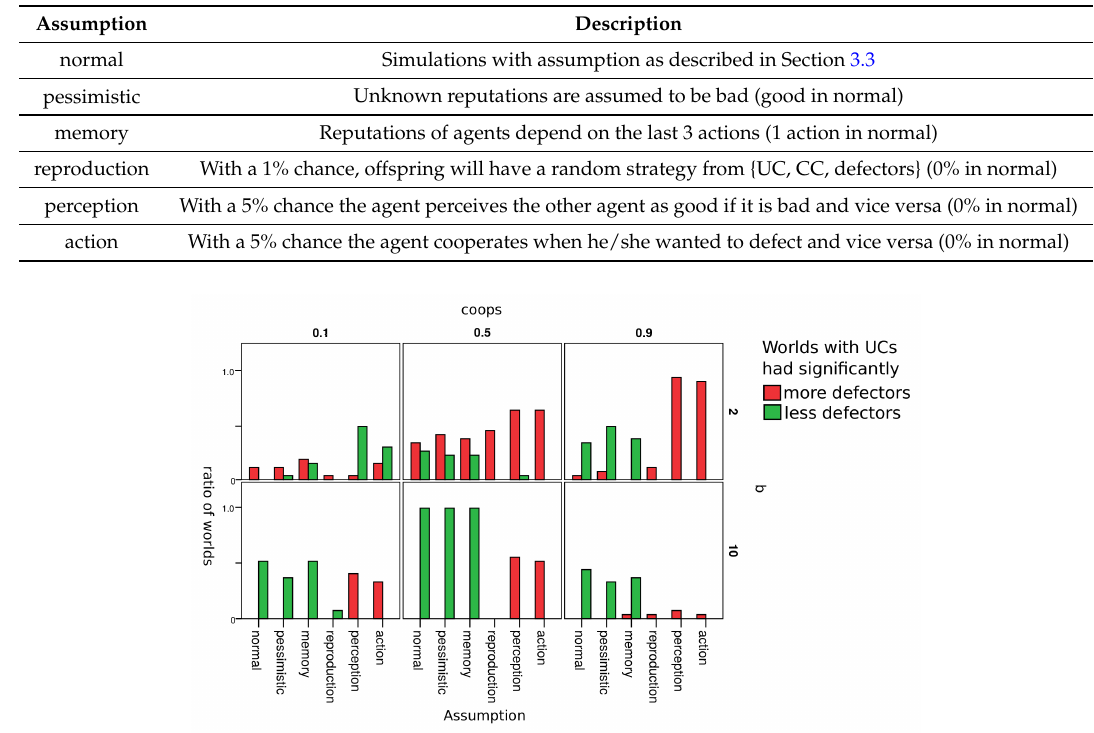
Table 4. List of assumptions changed as the robustness check.